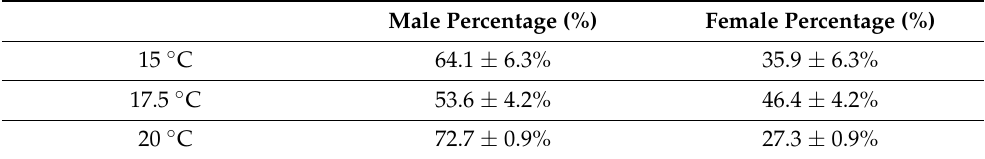
Table 1. Percentages and ± standard deviation of European sea bass males and females at the adult stage, which were grown at three different rearing temperatures from the egg stage until metamorphosis. The difference to the expected 1:1 ratio was tested by the chi-squared test, p < 0.005. Male Percentage